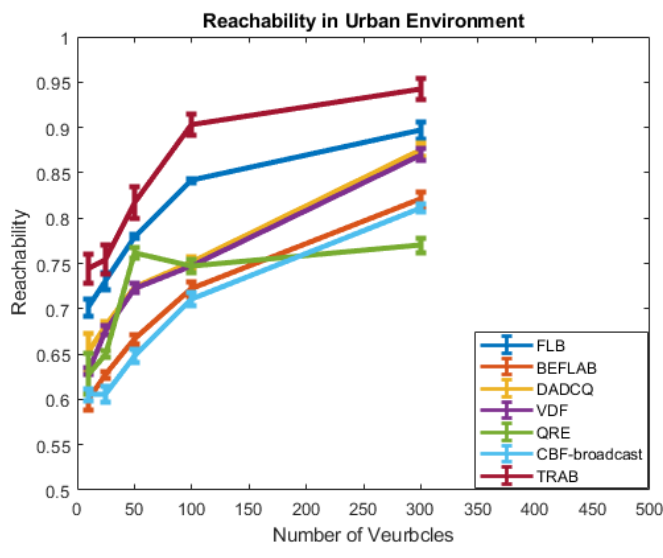
Figure 14. Urban reachability.